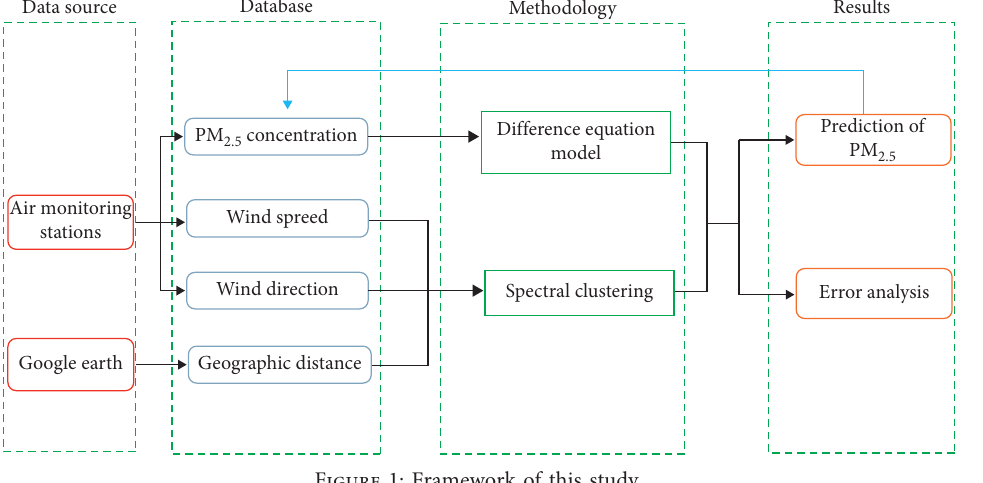
Figure 1: Framework of this study.